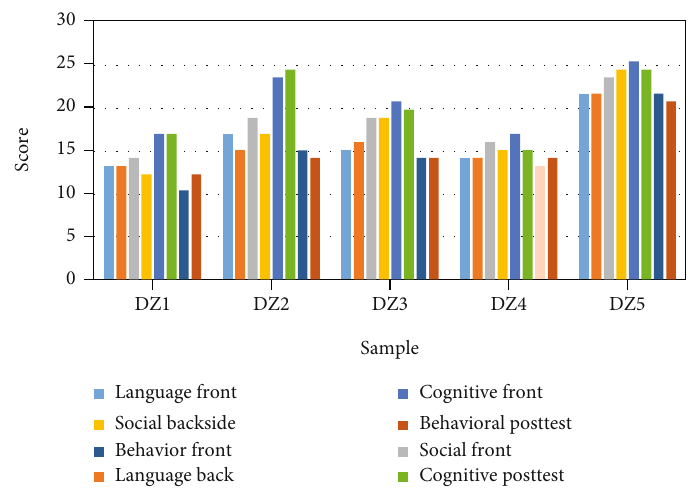
Figure 6: Visual chart of the scores of each subscale of ATEC before and after the 5 children in the control